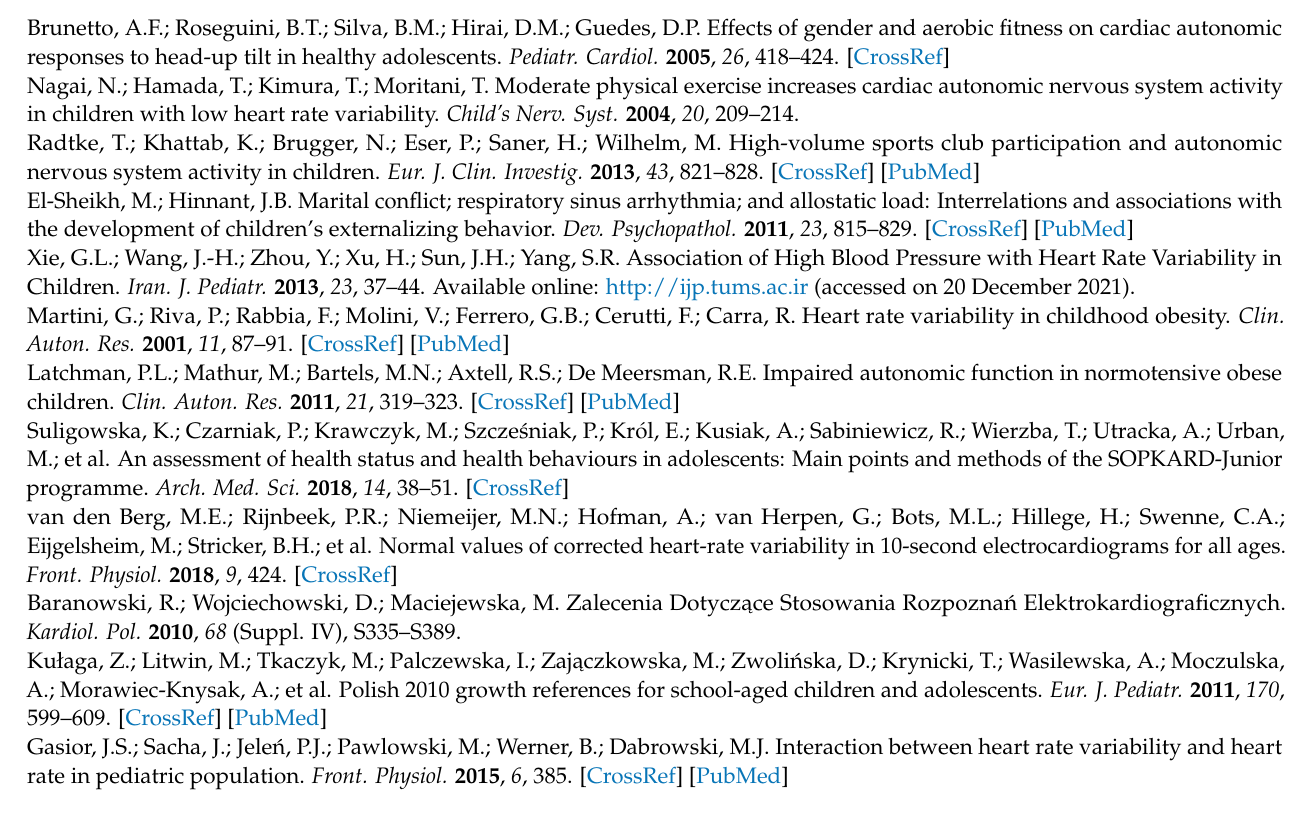
students (5–85 pc of BMI) compared to the group with overweight and obesity (BMI > 85 pc), Figure S2: A box-plot showing RMSSD in subjects with normal-weight students (5–85 pc of BMI) compared to the group with overweight and obesity (BMI > 85 pc), Figure S3: A box-plot showing RMSSDc in subjects with normal-weight students (5–85 pc of BMI) compared to the group with overweight and obesity (BMI > 85 pc), Figure S4: A scatter chart showing interdependence between heart rate and pvRSA, Figure S5: A scatter chart showing interdependence between heart rate and RMSSD, Figure S6: A scatter chart showing interdependence between heart rate and